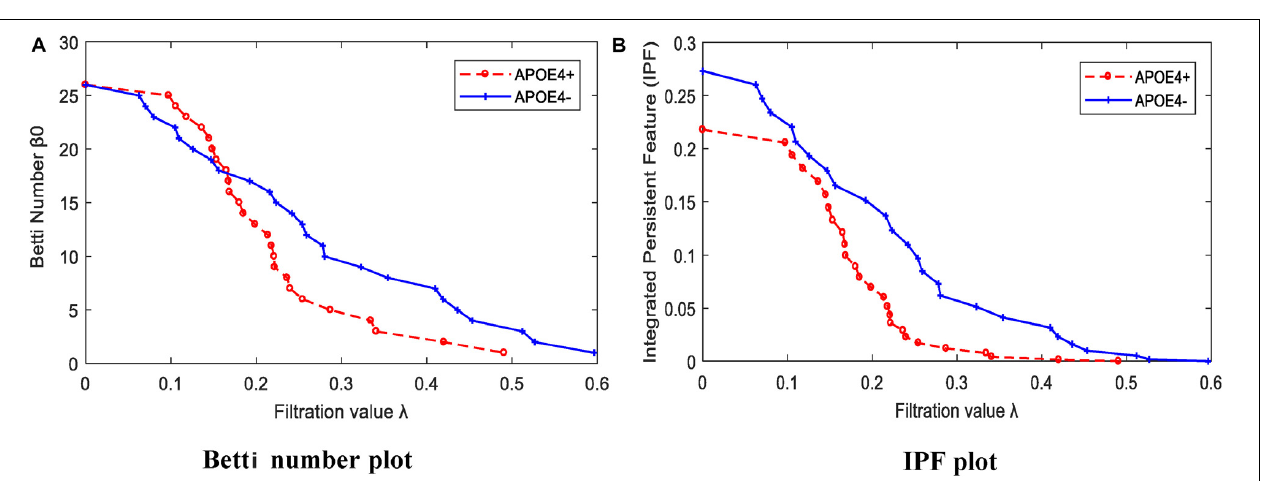
FIGURE 4 | The single linkage dendrograms of (A) APOE4 carriers and (B) non-carriers groups show the change of the zeroth Betti number. The color represents the target distance (total edge weight) from current connected component to the full connected component (the rightmost line).